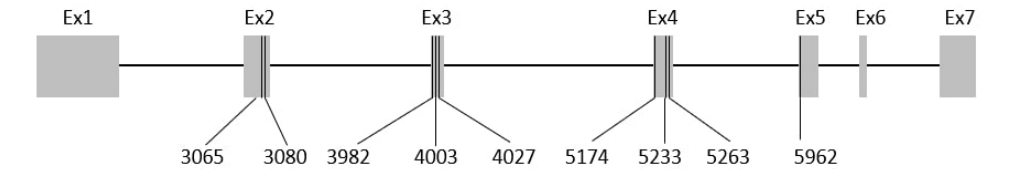
Figure 1. Nine progestogen-associated endometrial protein ( PAEP ) gene single nucleotide polymorphisms described in the present study with their nucleotide location within PAEP. Nucleotide position on the gene is presented according to Bos taurus reference genome ARS-UCD1.2. Ex1- Ex7 represents the number of PAEP exon.